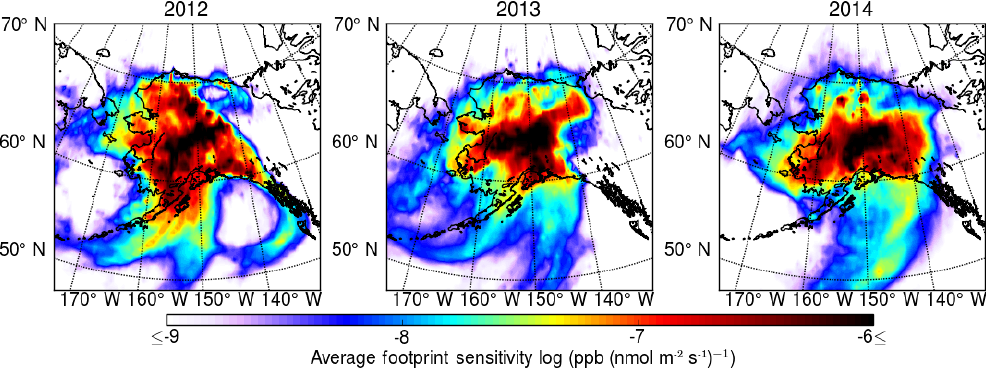
Figure 2. The average footprint sensitivity calculated from WRF–STILT is shown for all receptor points modelled within the profiles included in the analysis